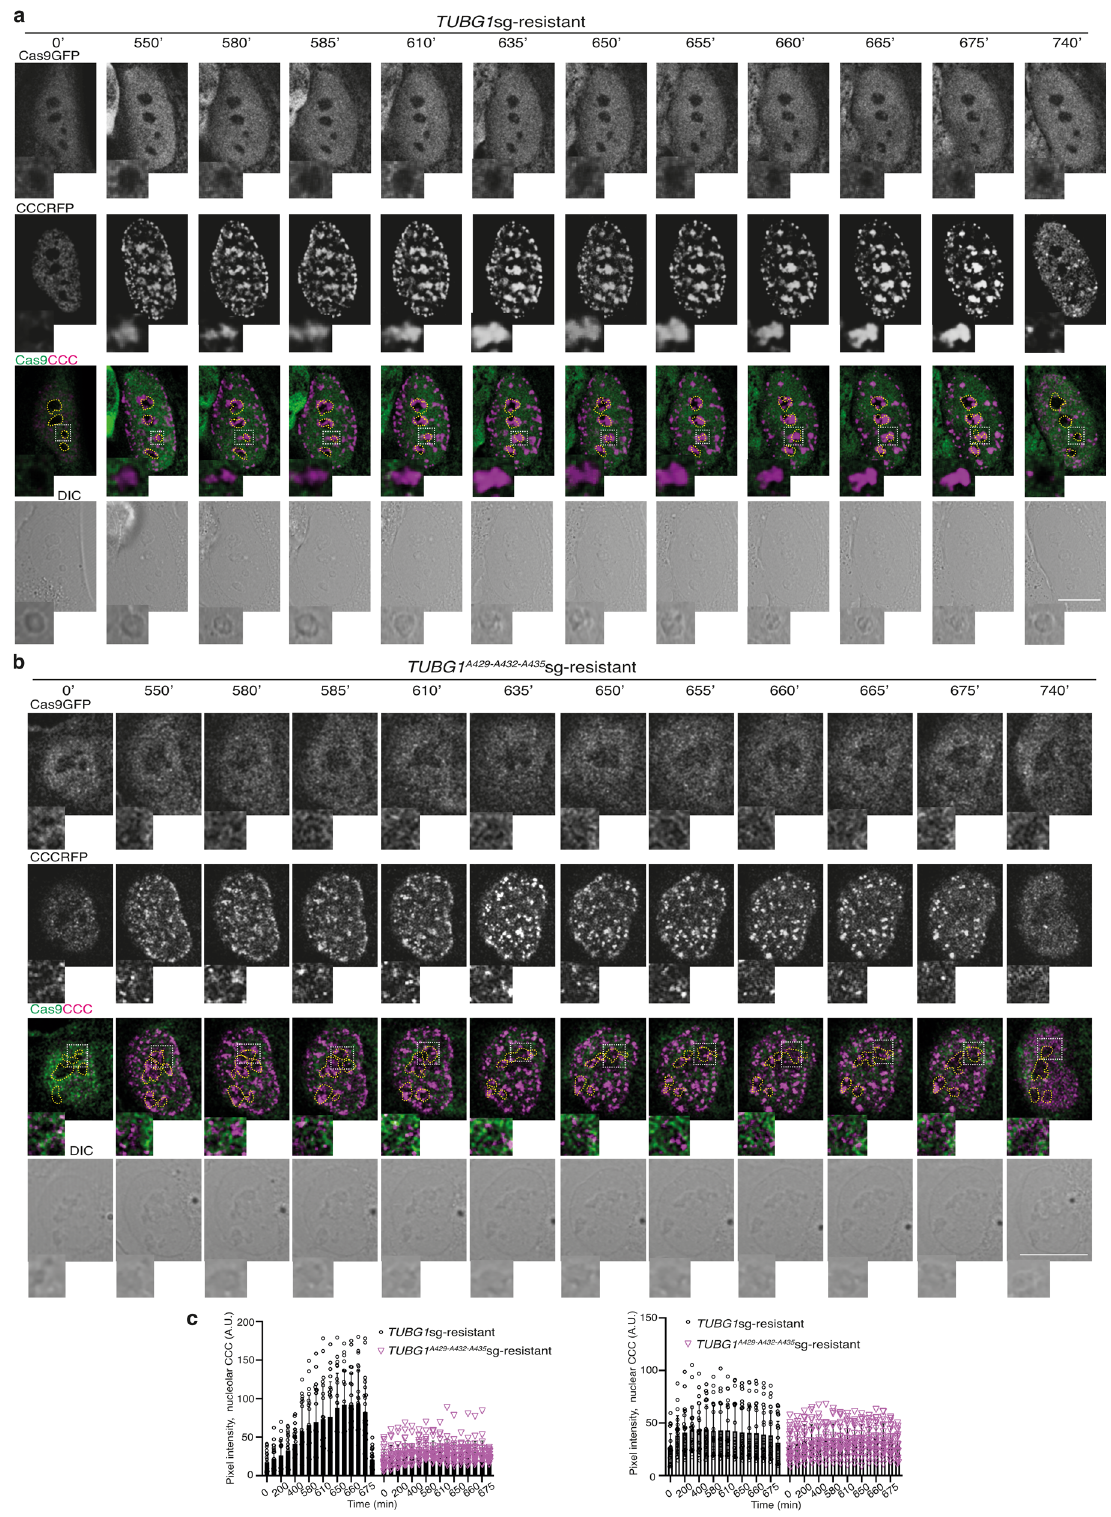
Fig. 7 The γ -tubulin PIP mutant reduced the size of CCC complexes formed in the nucleus. a , b The DIC/ fl uorescence images show time-lapse series of a stable TUBG sg-U2OS cell co-expressing either γ -tubulin resist ( a ) or a γ -tubulin A429-A432-A435 resist ( b ) and cell cycle chromobody (CCCRFP). The image series present chosen frames illustrating the accumulation of CCCRFP and how mutations in the γ -tubulin PIP motif affect the formation of CCCRFP foci ( N = 30 cells). Scale bars: 10 μ m (see also Supplementary Fig. 9). c The graphs show the time-dependent changes in fl uorescence intensity in the nucleolus and nuclear compartment as indicated by the cells in a , b (AU; mean ± SD; N = 22 cells, *** P < 0.001). Source data are provided in Supplementary Data